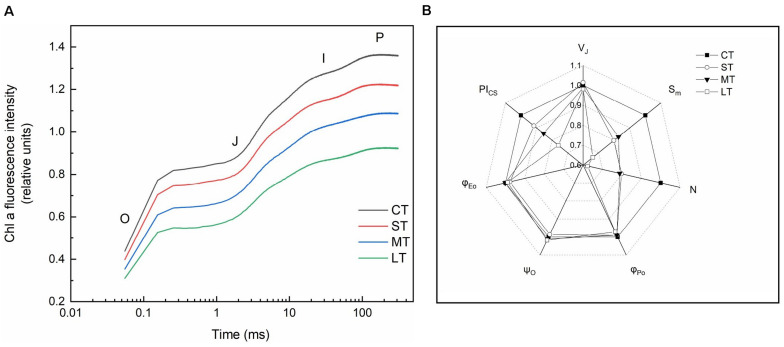
Rapid chlorophyll fluorescence induction kinetics. (A) OJIP transient (values are means of three replicates). (B) The spider plots of the chlorophyll fluorescence parameters in different treatments. VJ: Relative variable fluorescence intensity at J point. Sm: The complementary area between the O-J-I-P induction curve, F = FM and the Y-axis. N: The number of times that QA was restored during the period from the start of illumination to FM. φPo: Maximal photochemical efficiency. ψO: The ratio of the excitons captured by the reaction center to the other electron acceptors used to promote electron transfer to the electron transfer chain, which exceeds QA, to the excitons used to promote QA reduction. φEo: Quantum yield for electron transfer. PICS: Performance index based on unit area. All data are expressed as means ± SD based on experiments in triplicate. CT: Control group without any air exposure; ST: 1 h of daily air exposure; MT: 2 h of daily air exposure; LT: 4 h of daily air exposure.